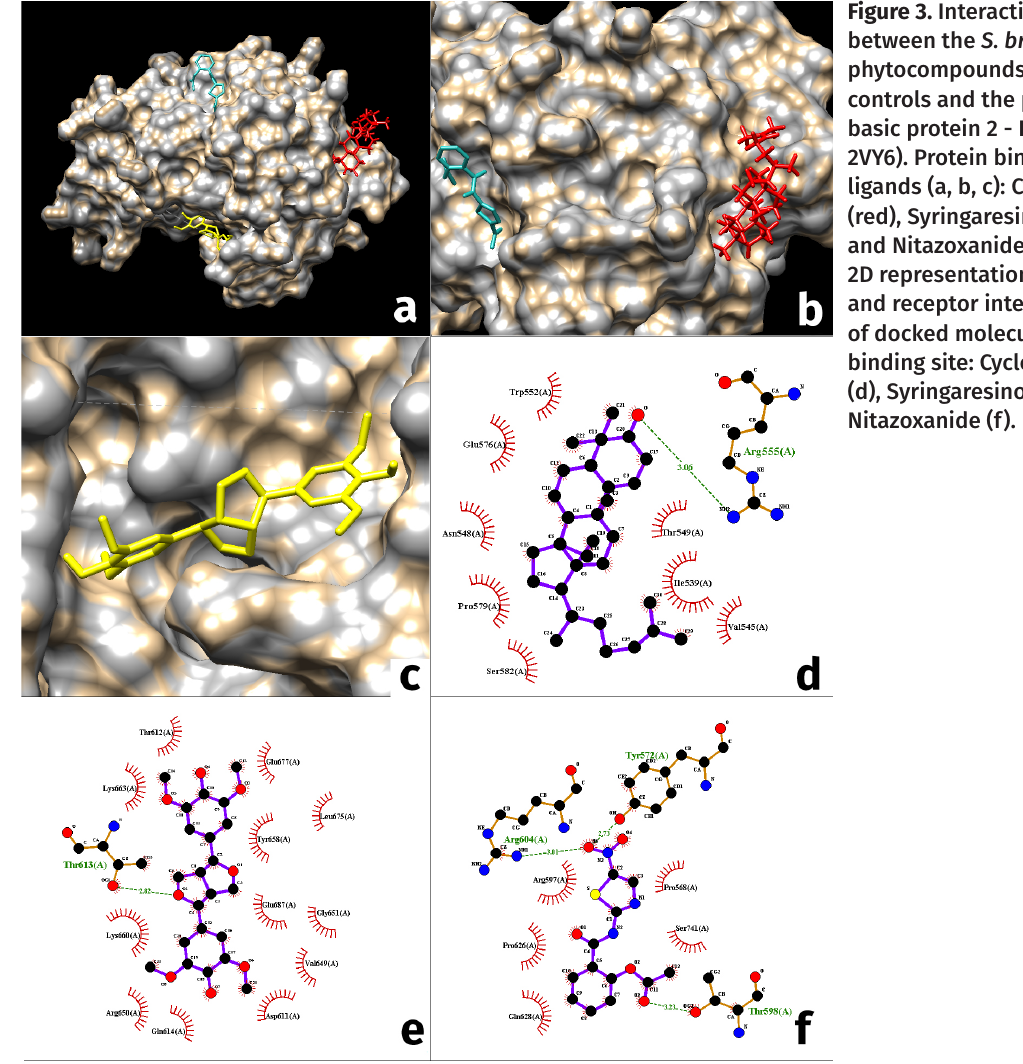
Figure 3. Interactions between the S. brasiliensis phytocompounds, positive controls and the polymerase basic protein 2 - PB2 (PDB 2VY6). Protein binding site and ligands (a, b, c): Cycloartenone (red), Syringaresinol (yellow) and Nitazoxanide (light sea, 2D representation of ligand and receptor interaction plots of docked molecules into binding site: Cycloartenone (d), Syringaresinol (e) and Nitazoxanide